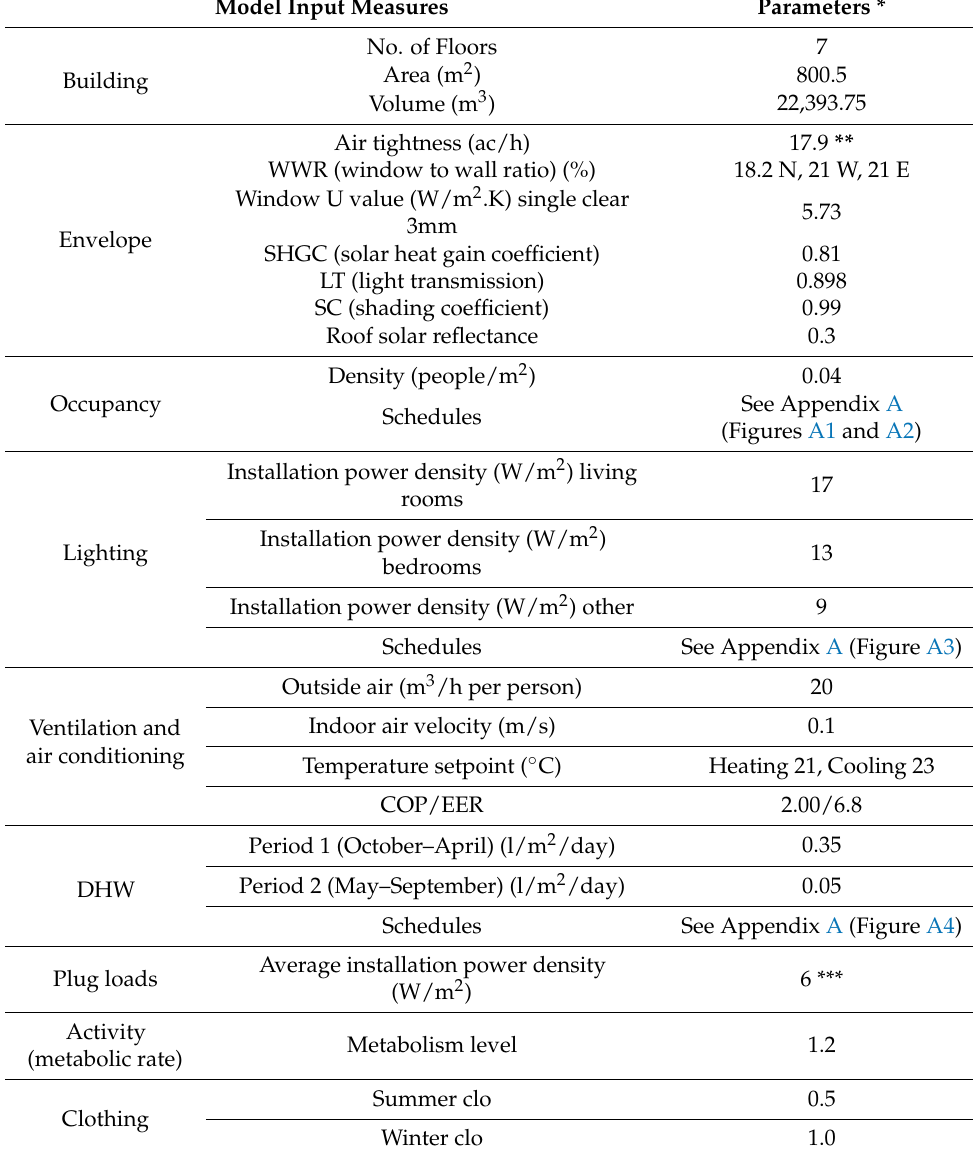
Table 3. Input parameters of the base case (simulation